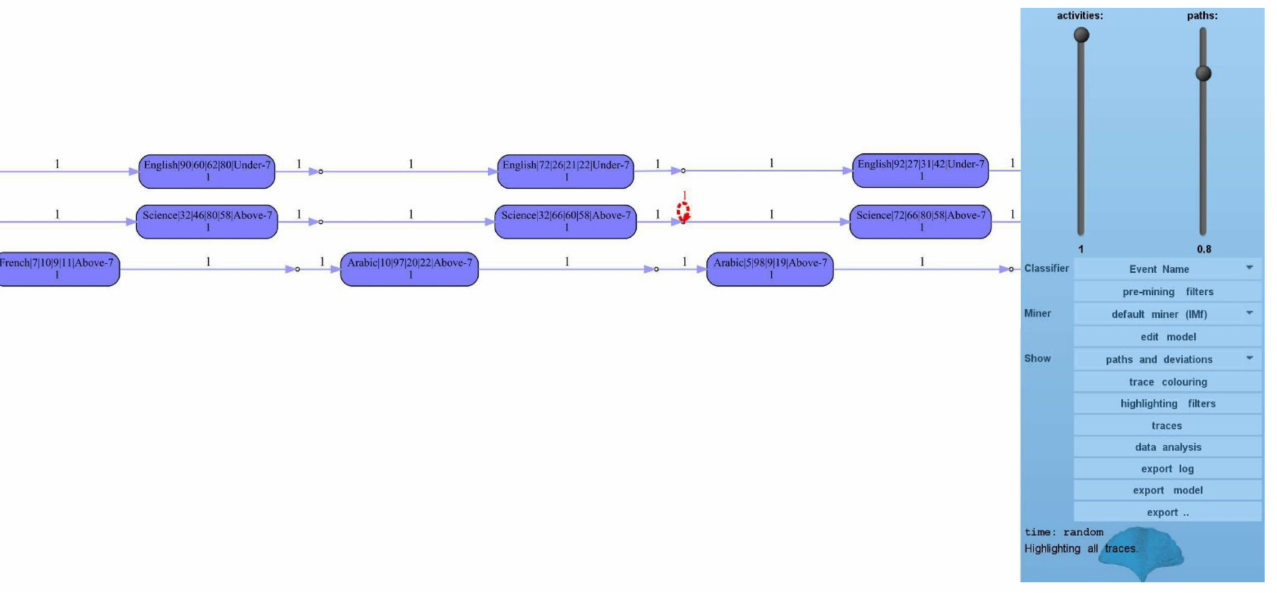
Figure 14. IvM model with log deviations.